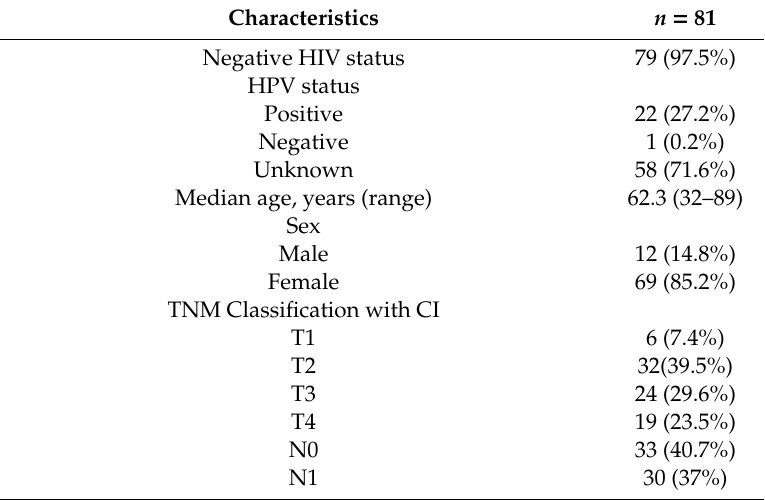
Table 1. Patient